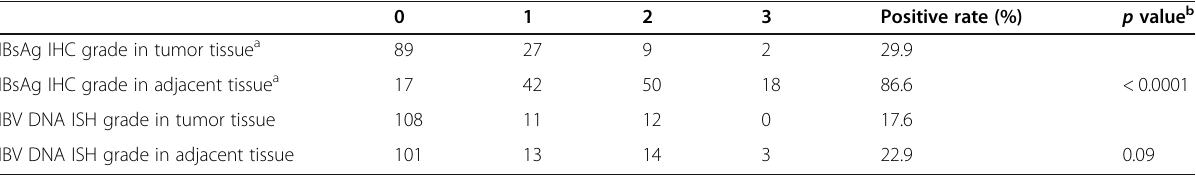
Table 2 The summary of molecular pathological results in tumor and surrounding tissues 0